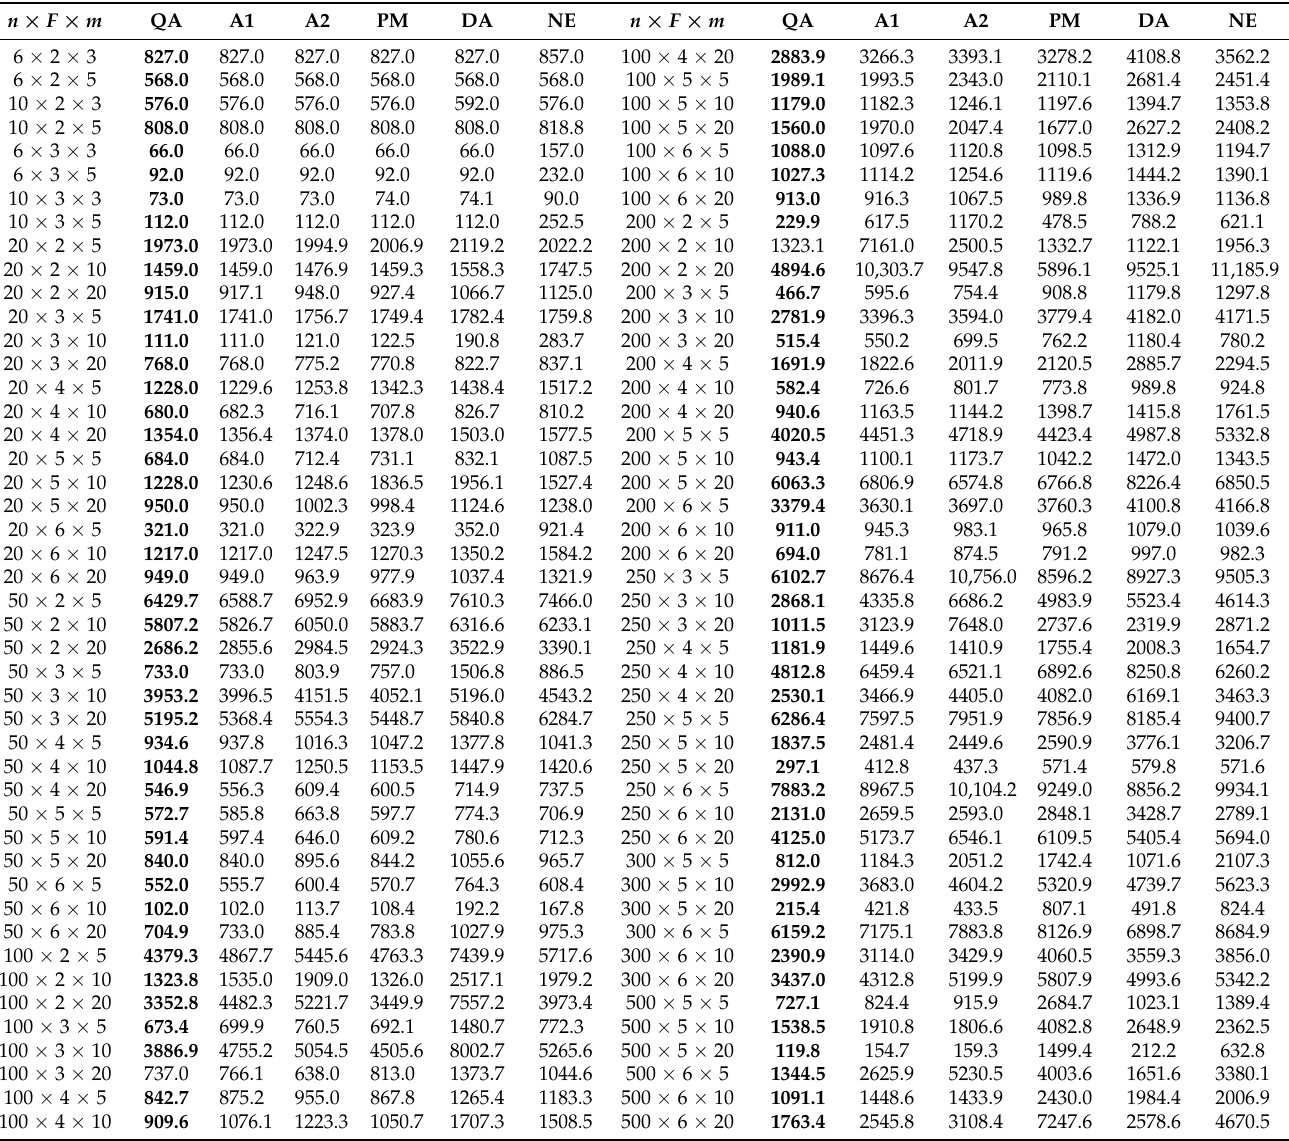
Table 7. Computational results of Avg by six